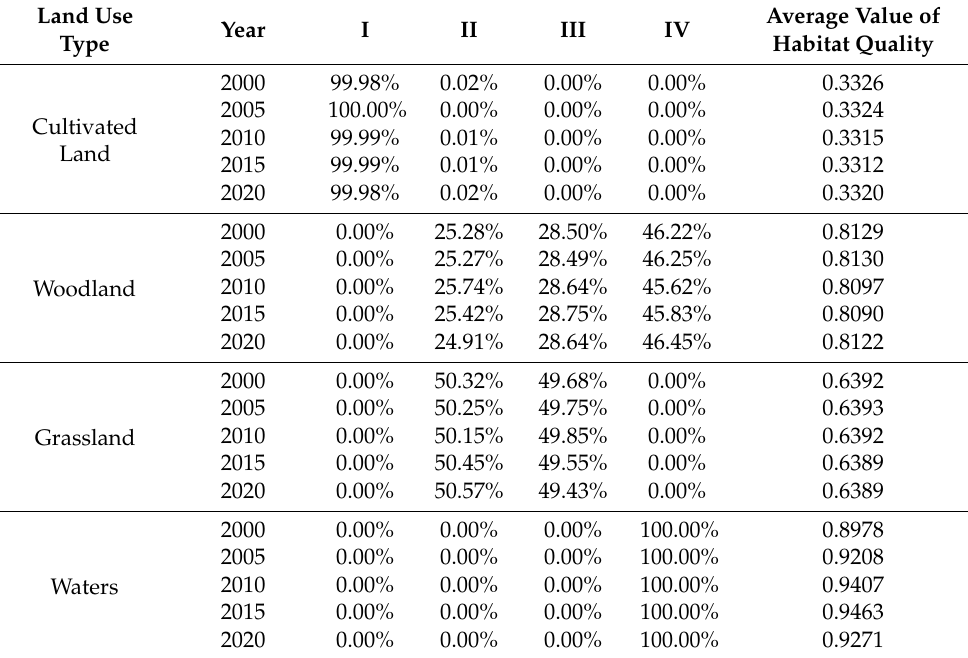
Table 5. Habitat quality change of different land use types in Shiyan from 2000 to